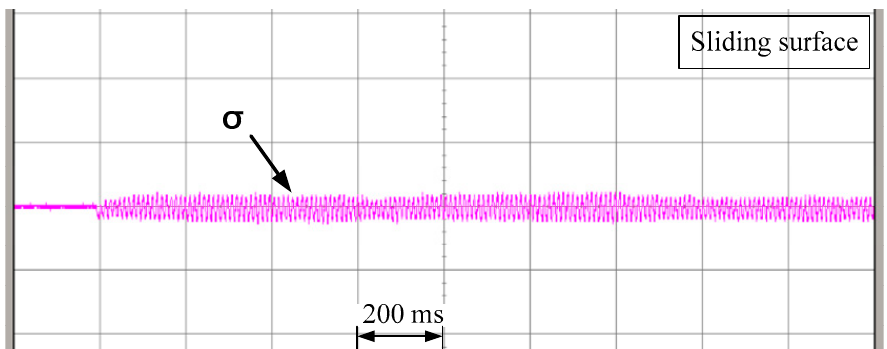
Figure 22. The sliding surface σ without the load added.